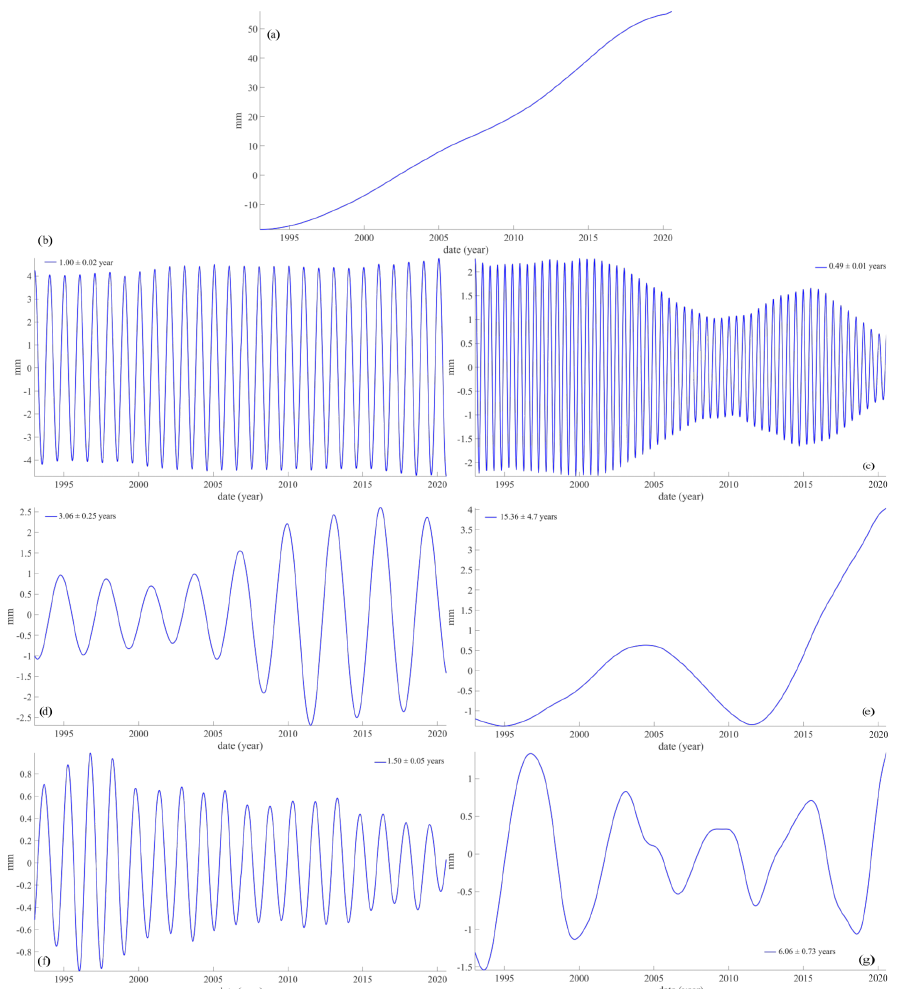
Figure 11. First seven components extracted by SSA from GSL data series. First SSA component (trend) of the GSL data series of Figure 10. Second SSA component (1 yr) of the GSL data series. Third SSA component (0.5 yr) of the GSL data series. Fourth SSA component (3 yr) of the GSL data series. Fifth SSA component (15 yr) of the GSL data series. Sixth SSA component (1.5 yr) of the GSL data series. Seventh SSA component (6 yr) of the GSLs data